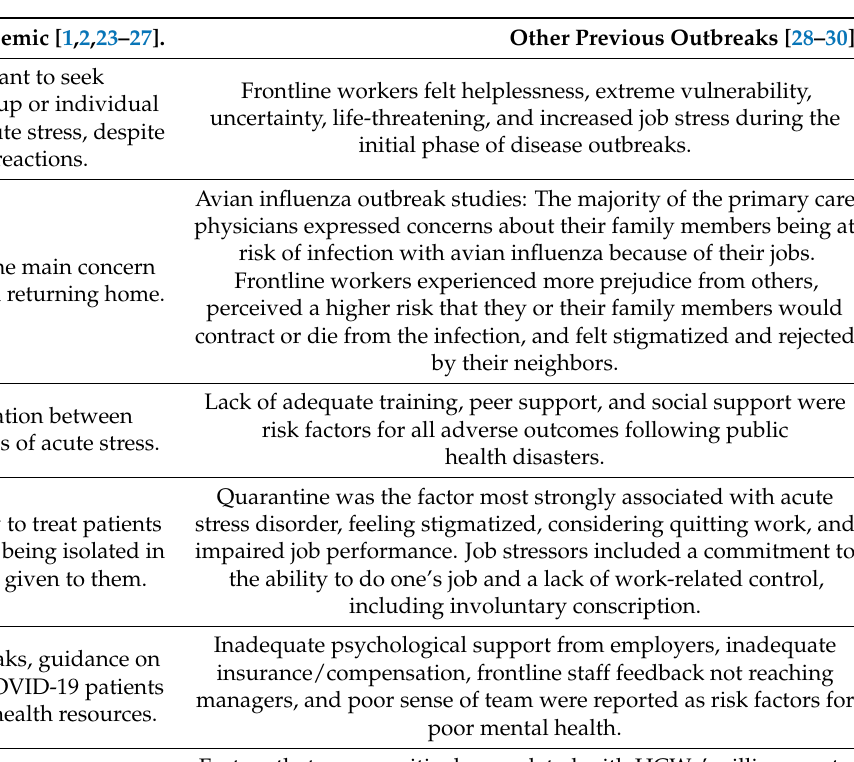
Table 1. Summary of results of the pragmatic literature review of studies on stress and affective reactions of professionals who attended patients with COVID-19 compared to previous